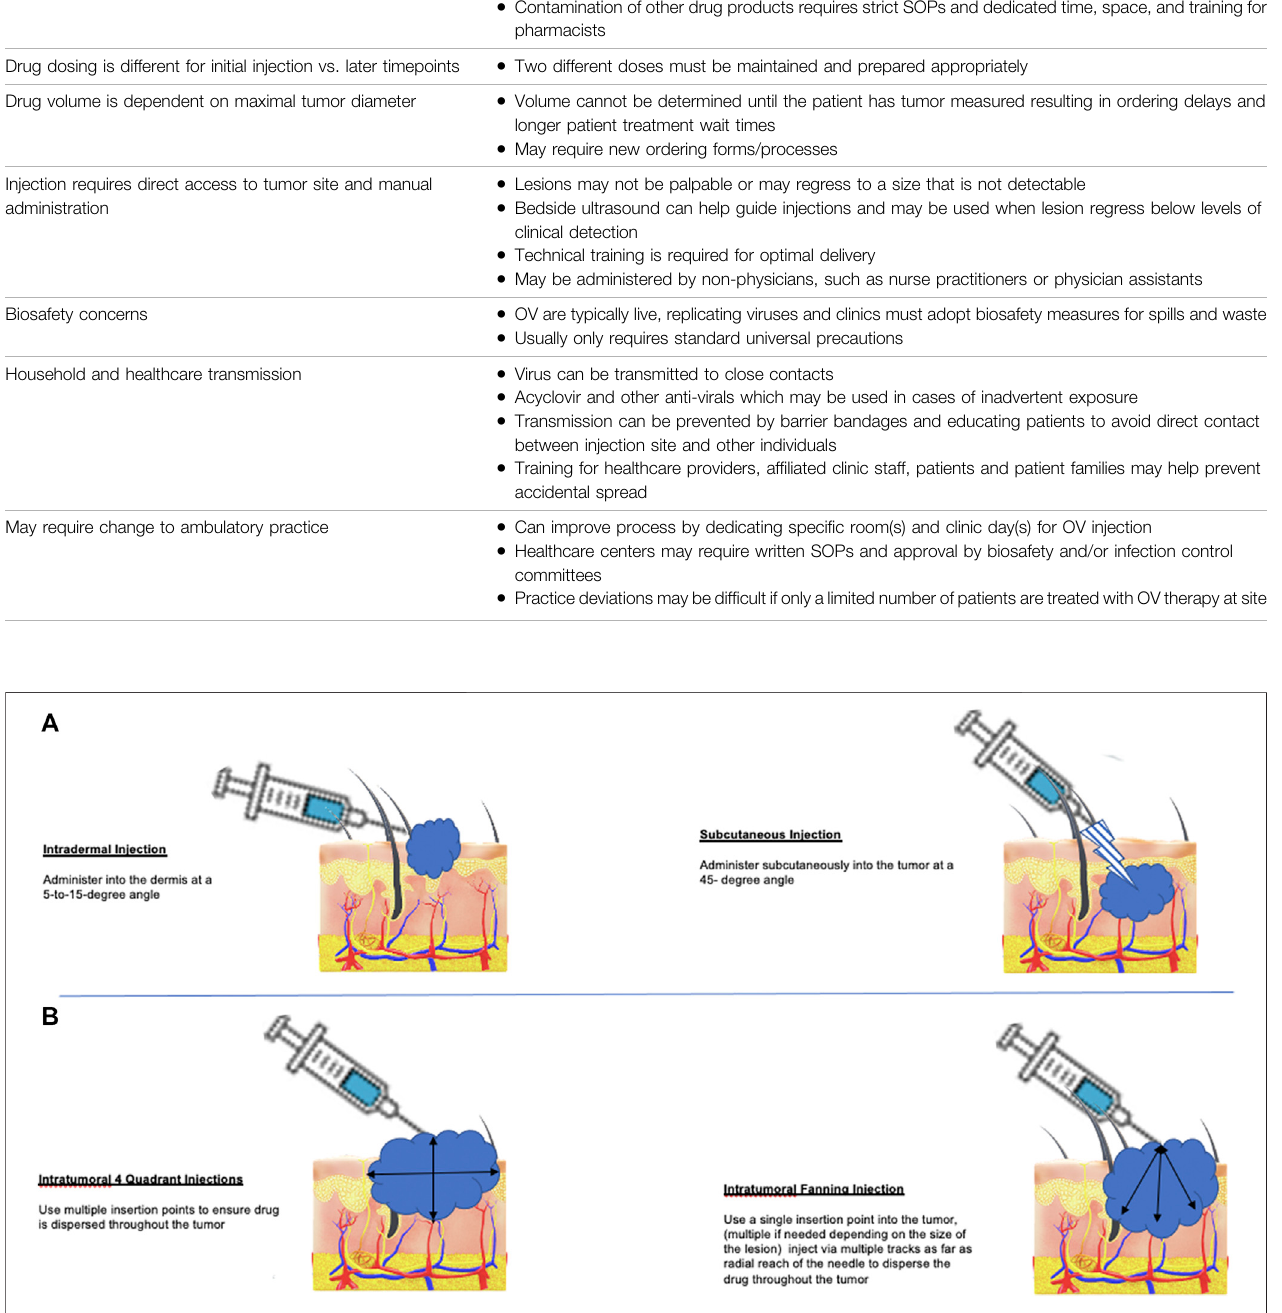
Frontiers in Molecular Biosciences |